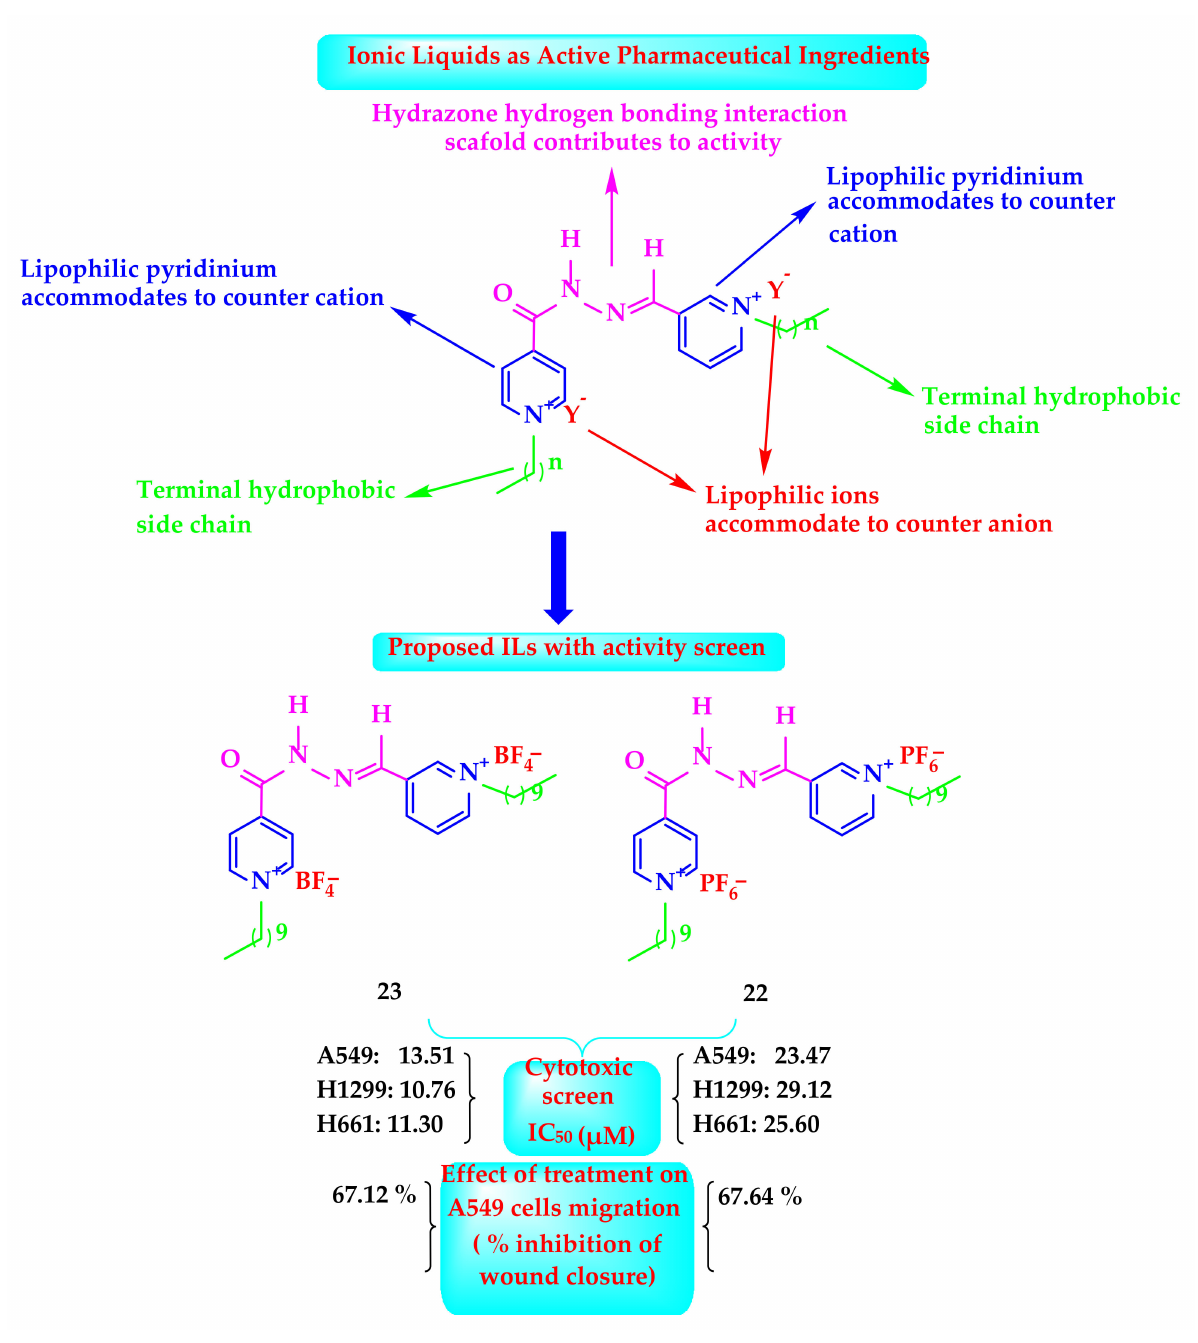
Figure 1. Schematic representation of the proposed